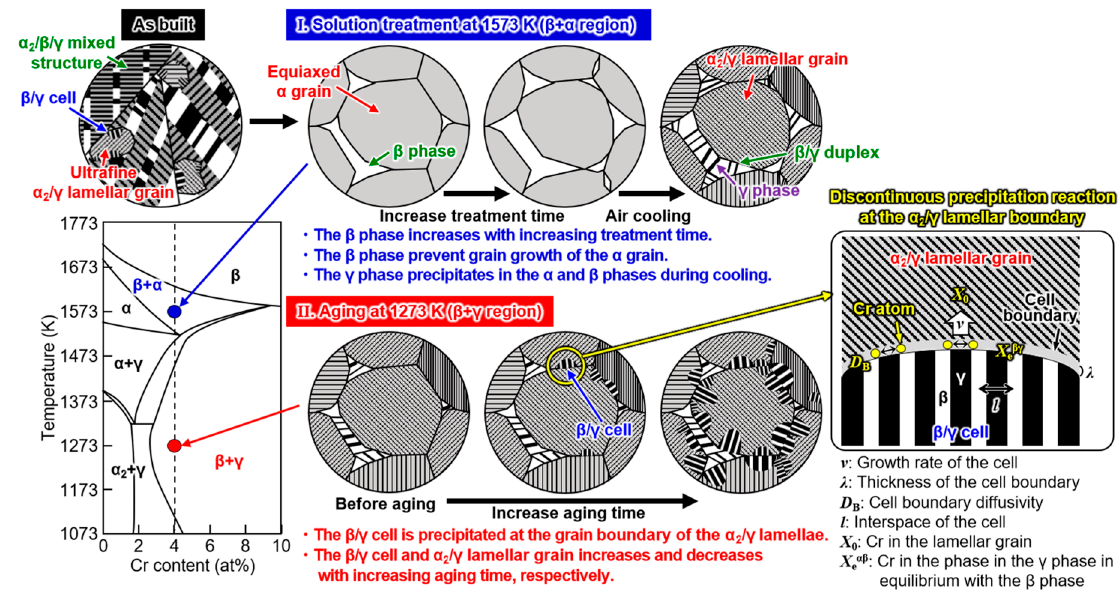
Figure 5. Schematic drawing of microstructural evolution during the two-step heat treatment of the 44-4 alloy rods fabricated by EBM.